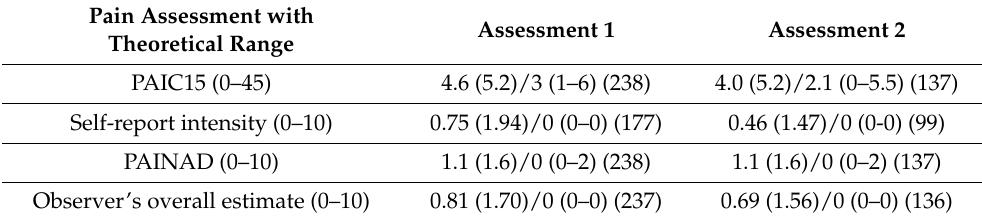
Table 2. Pain assessments mean, (SD)/median (IQR) (n).